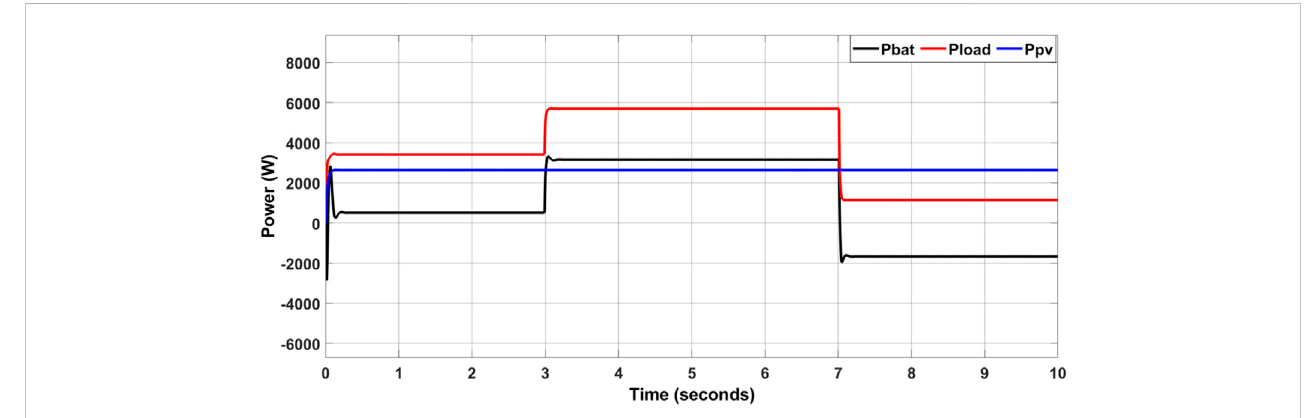
FIGURE 13 Power curves of the PV system, load and battery.